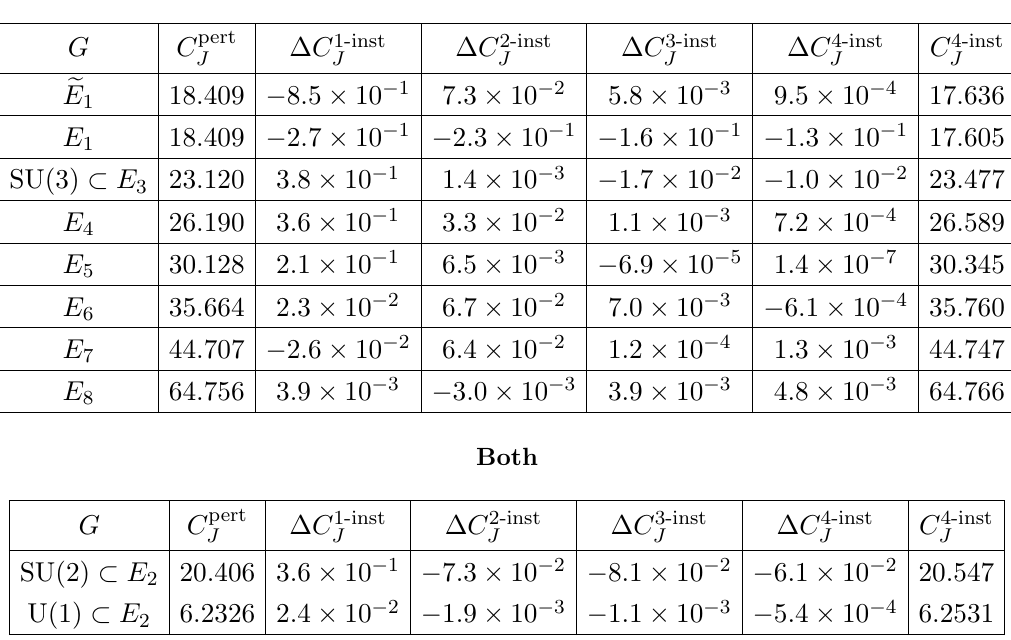
at each instanton number J